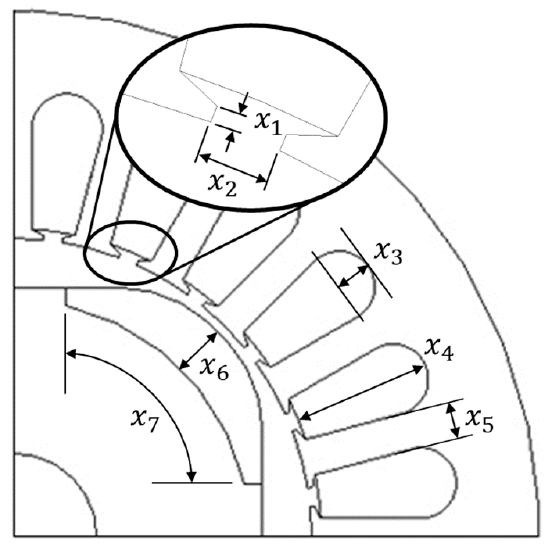
Figure 9. Design variables of the BLDC motor.